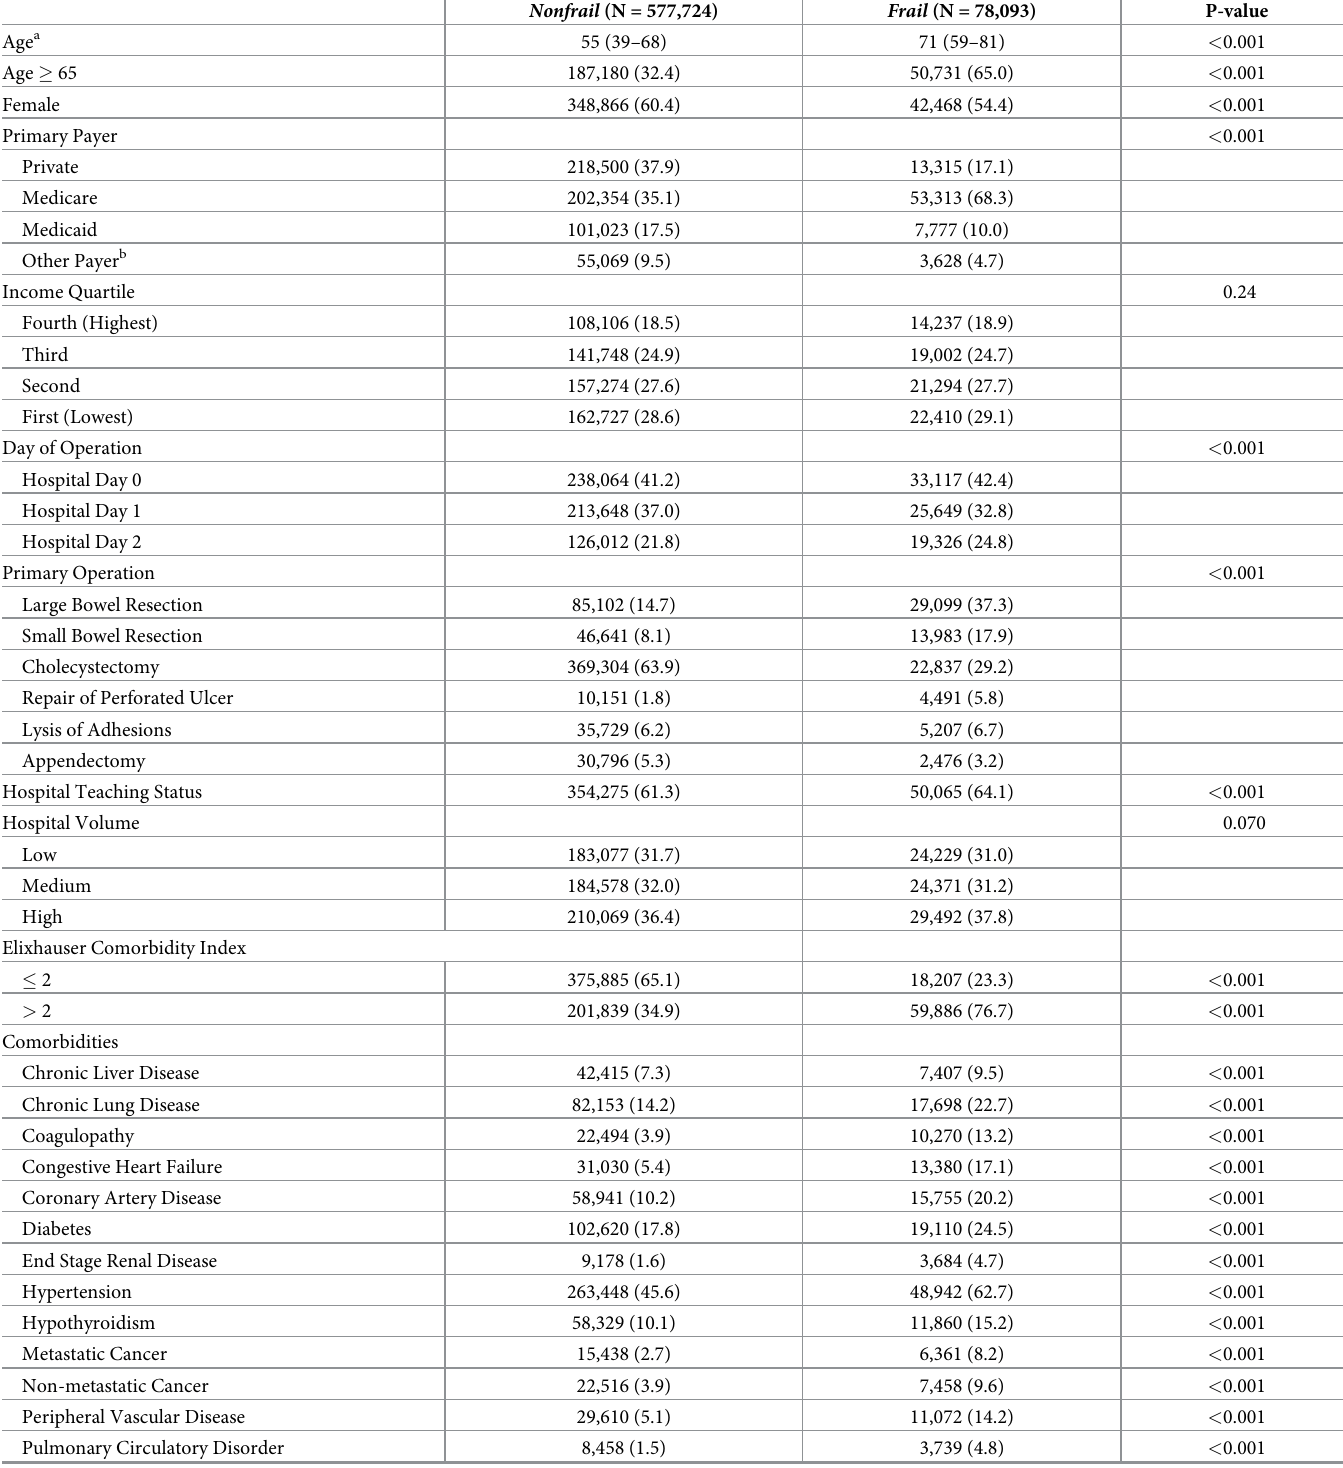
Table 1. Demographics and characteristics of patients undergoing EGS